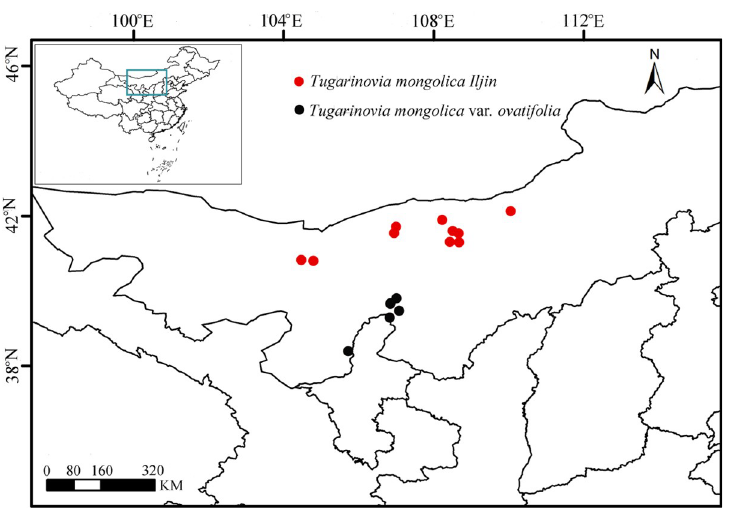
Fig 1. Study regions of Tugarinovia mongolica . Red dots represent T . mongolica , and black dots represent T . mongolica var. ovatifolia